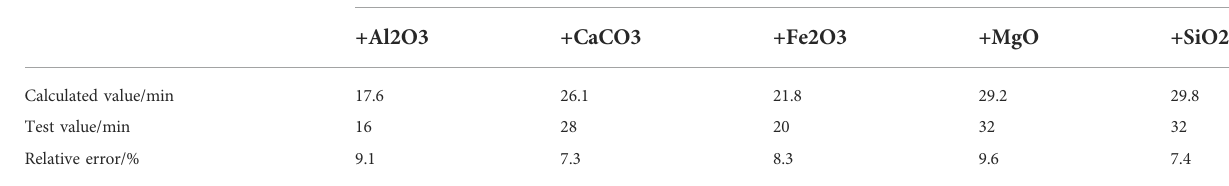
TABLE 8 Demulsi fi cation time of the SDBS emulsi fi ed asphalts. Demulsi fi cation time